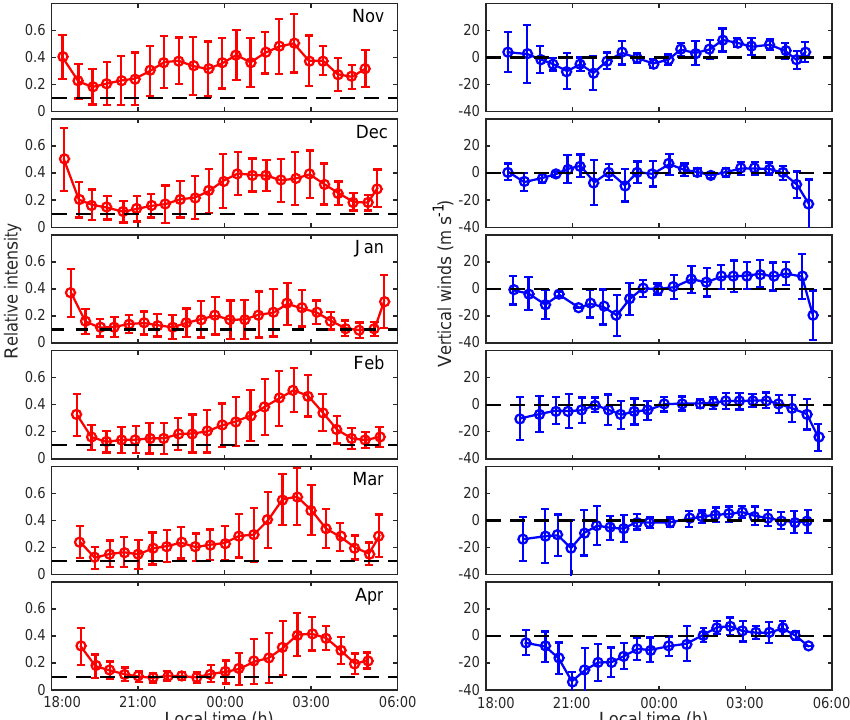
Figure 5. The relative intensity (red curves) and vertical winds (blue curves) averaged for a time bin of 30min using data for all viewing directions. The vertical bars show the overall range of variation within each averaging